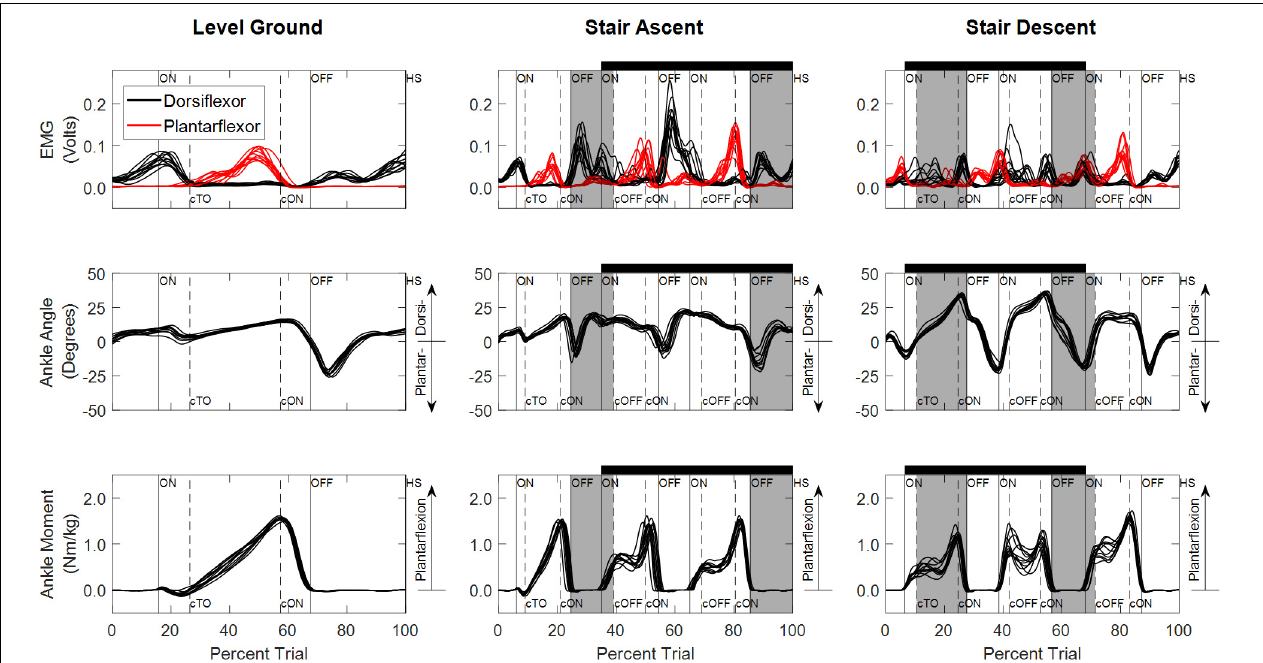
FIGURE 3 | Experimentally measured linear envelope of EMG signals, ankle angle, and ankle moment for level overground walking, stair ascent, and stair descent of a typical participant (S04). Percent trial is normalized from 225 ms before first heel strike on the first force plate to the first heel strike before contralateral toe off of the last force plate. Vertical lines denote gait events (solid: limb used to train the model; dashed: contralateral limb) defined based on force plate and floor contact (ON, first contact on force plate; OFF, last contact on force plate; HS, heel strike on floor; TO, toe off on floor). Contralateral gait events are identified by a lowercase “c” (e.g., cTO, contralateral toe off). Staircase ambulation (black horizontal bar) is defined as the first foot contact on the staircase to the first foot contact on level ground of the limb used during training. Staircase transitions to/from level ground are shaded gray. Double limb support occurs when both feet are in contact with the ground simultaneously (ON to cTO or ON to cOFF and cON to